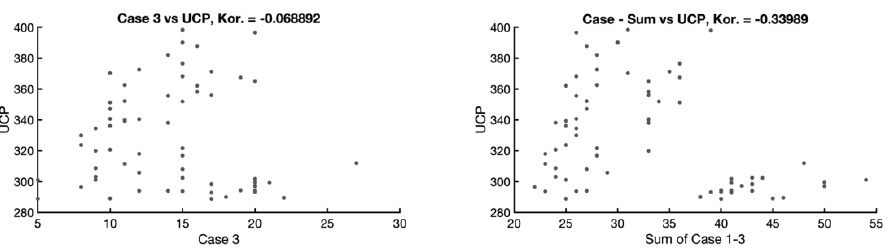
Figure 5. Correlation between use cases and real size in UCP.